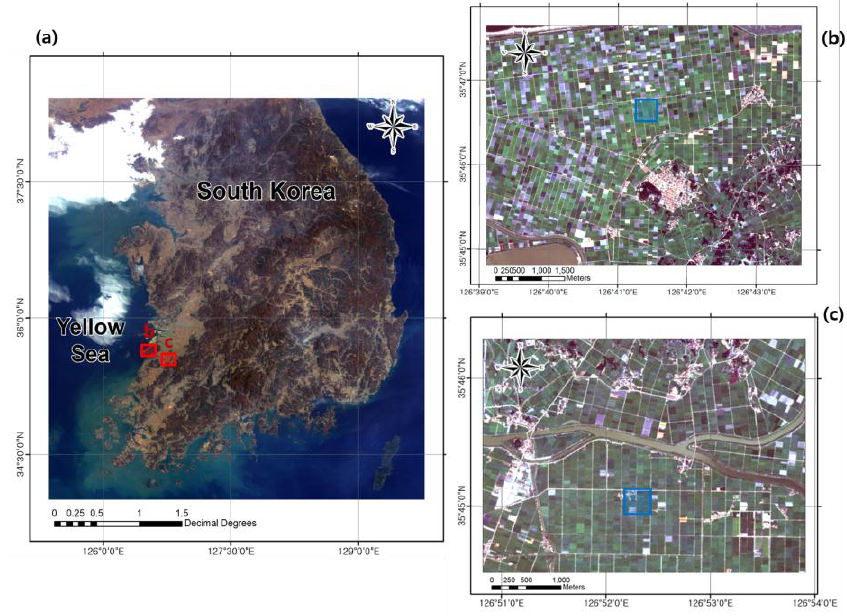
Figure 1. Study area. ( a ) Red Green Blue (RGB) color composite image from the Geostationary Ocean Color Imager (GOCI) acquired on 1 April 2011. The red rectangles, ( b ) and ( c ), in (a) are shown in (b), and (c), respectively, giving detailed views using high-resolution RapidEye multispectral data obtained on 5 August 2011 (b), and 11 October 2011 (c). The blue rectangles in (b), and (c) are geometrically matched with corresponding satellite observation